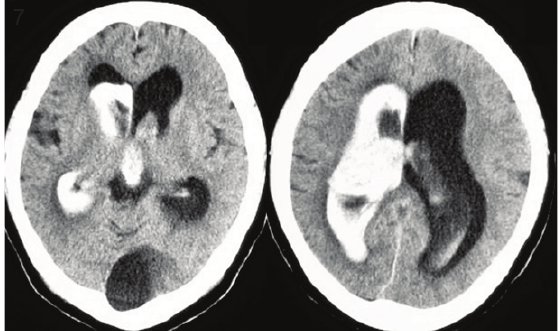
Figure 1. Head CT showinf intraventricular hemorrhage and acute